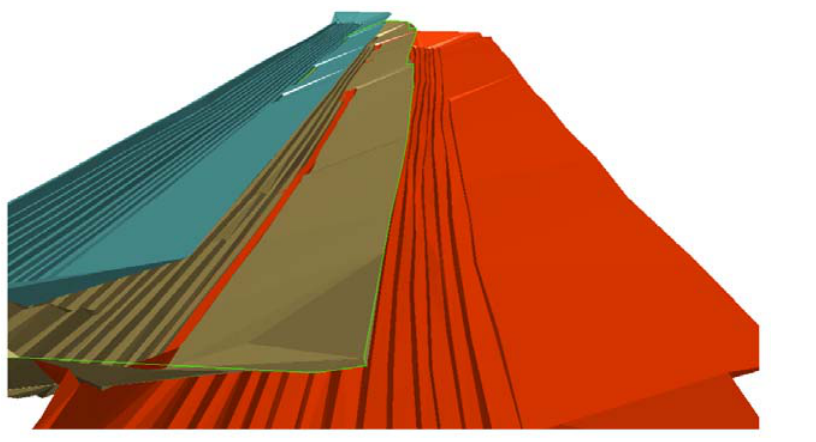
Figure 16 – DTM for years: 2013 (first on the left), 2014 (middle) and 2015 (right) Рис . 16 – ЦММ в 2013 году ( первое слева ), 2014 году ( в середине ) и 2015 году ( справа ) Слика 16 – ДМТ за године : 2013. ( први с леве стране ), 2014. ( средњи ) и 2015. ( десни